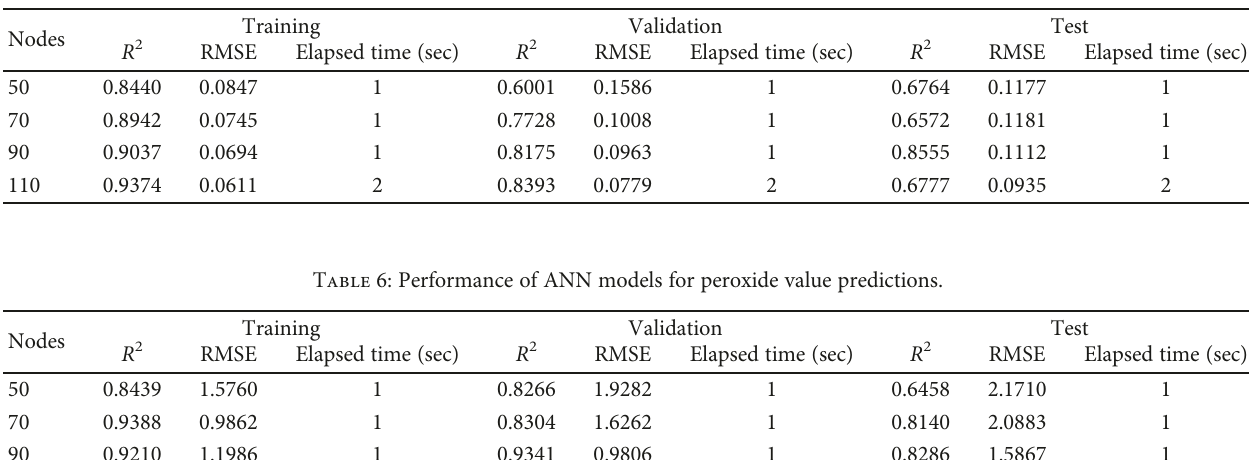
Table 5: Performance of ANN models for acid value predictions.